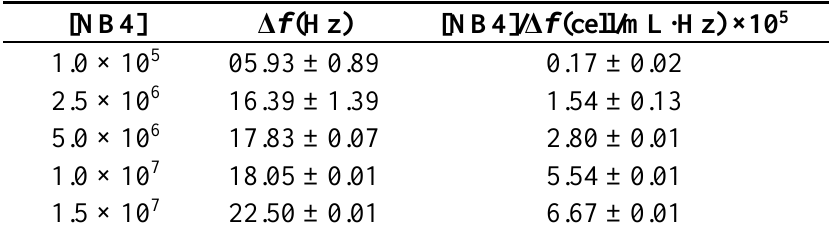
Table 2. Frequency shift variation of Artin-NB4